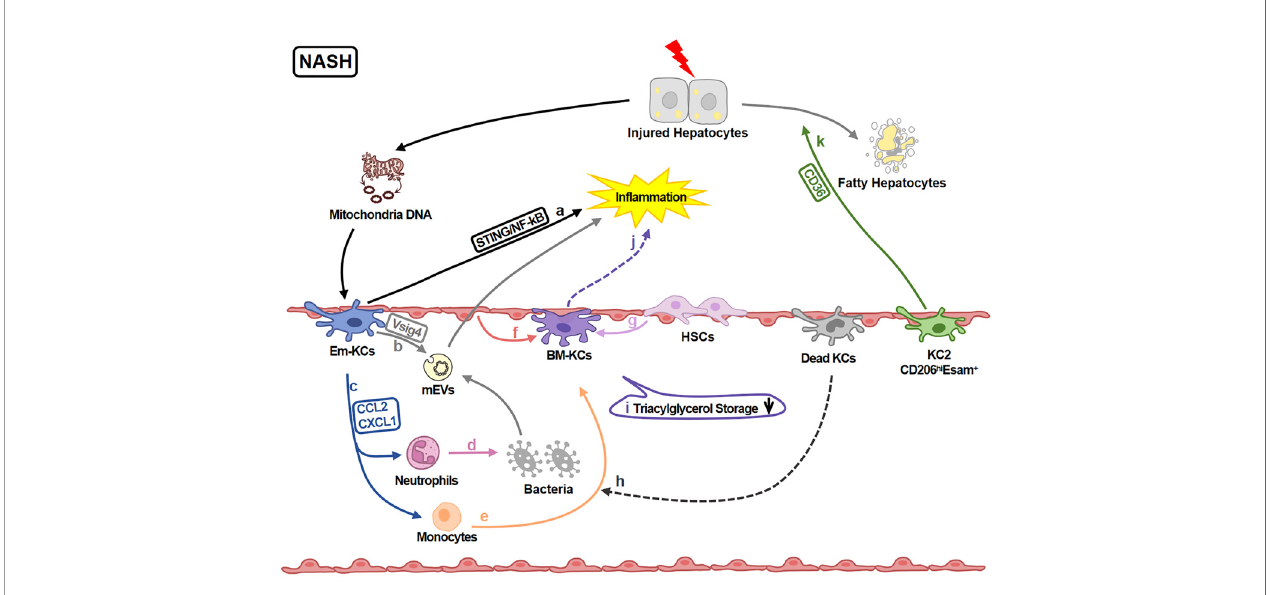
FIGURE 3 | KCs in NASH-related Liver Injury. In NASH livers, KCs regulate in fl ammation and lipid metabolism. (A) KCs-STING/NF-kB signaling is activated by mitochondria DNA from injured hepatocytes and amplify the in fl ammation. (B) KCs inversely engulf gut mEV (microbial DNA containing extracellular vesicles) via VSIG4 and attenuate in fl ammation. (C) KCs also secret chemokines CCL2 and CXCL1 recruiting neutrophils and monocytes. (D) Neutrophils help killing pathogens like bacteria. (E) Monocytes can differentiate into BM-KCs. (F, G) The differentiation process is regulated by LSECs and HSCs. (H) Dead KCs are the initiators of the replenishment by opening KC niche. (I) The triacylglycerol storage capacity of BM-KCs is decreased comparing to Em-KCs. (J) Meanwhile, BM-KCs promote in fl ammatory response. (K) KC2 (CD206 hi ESAM + KCs) regulate lipid metabolism via CD36 leading to the damage of